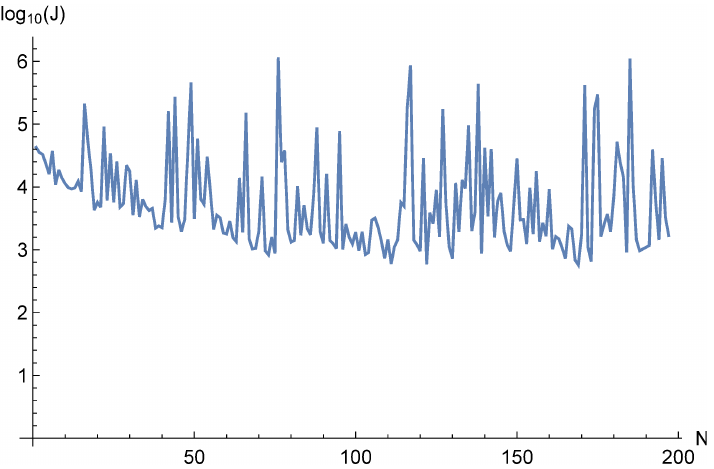
Figure 10. Plot of training loss J history of neural network solution nn 100 ( x , s ) (9) to problem (30), parameter value s = 0.01, with respect to number N of training epochs. Number of hidden layer neurons n = 20; sigmoid activation